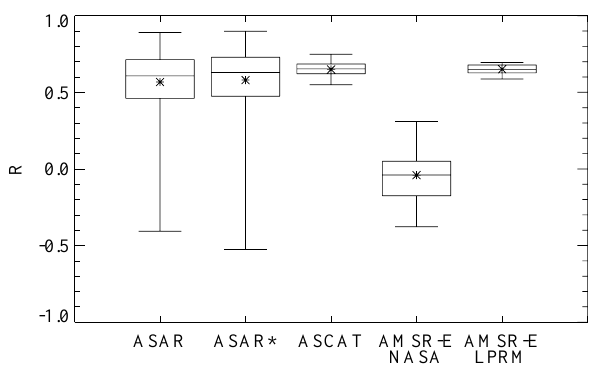
Fig. 11. Box plots of correlation coefficients between modelled soil moisture and ASAR soil moisture using a single angular correc- tion (ASAR), ASAR soil moisture using a seasonal angular correc- tion (ASAR*), TU Wien-EUMETSAT ASCAT surface soil mois- ture (ASCAT), AMSR-E soil moisture derived using the algorithm developed by Njoku et al. (2003) (AMSR-E NASA) and AMSR-E soil moisture derived using the Land Surface Parameter Model of Owe et al. (2008) (AMSR-E LPRM), for all pixels of the respective products over the study site. Crosses indicate the arithmetic